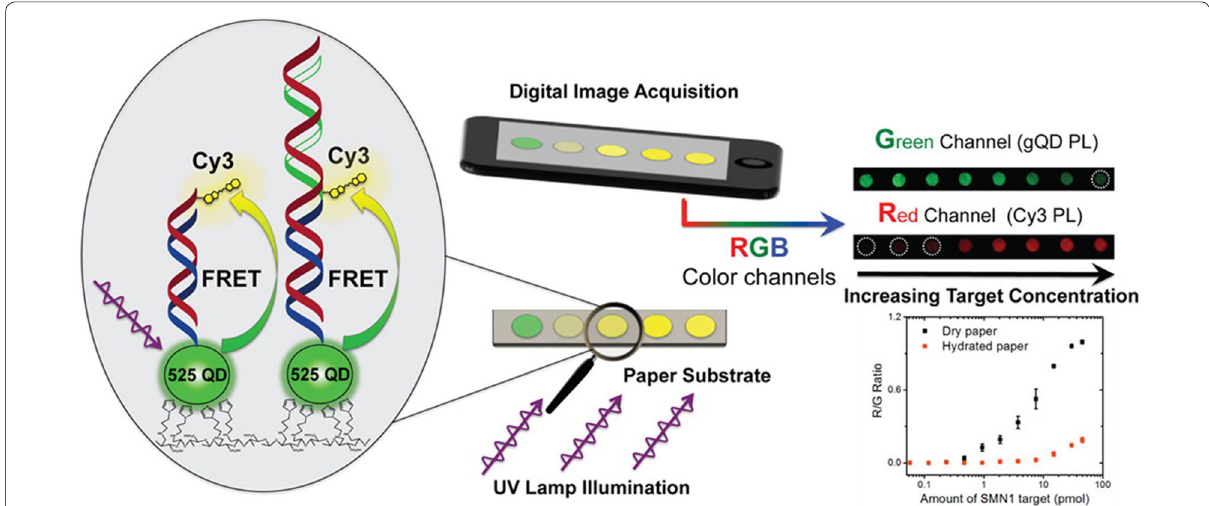
Fig. 2 Mechanism and process of ratiometric FRET‑sensitized emission to detect nucleic acid hybridization (reproduced from [52] with permission, © 2014 American Chemical